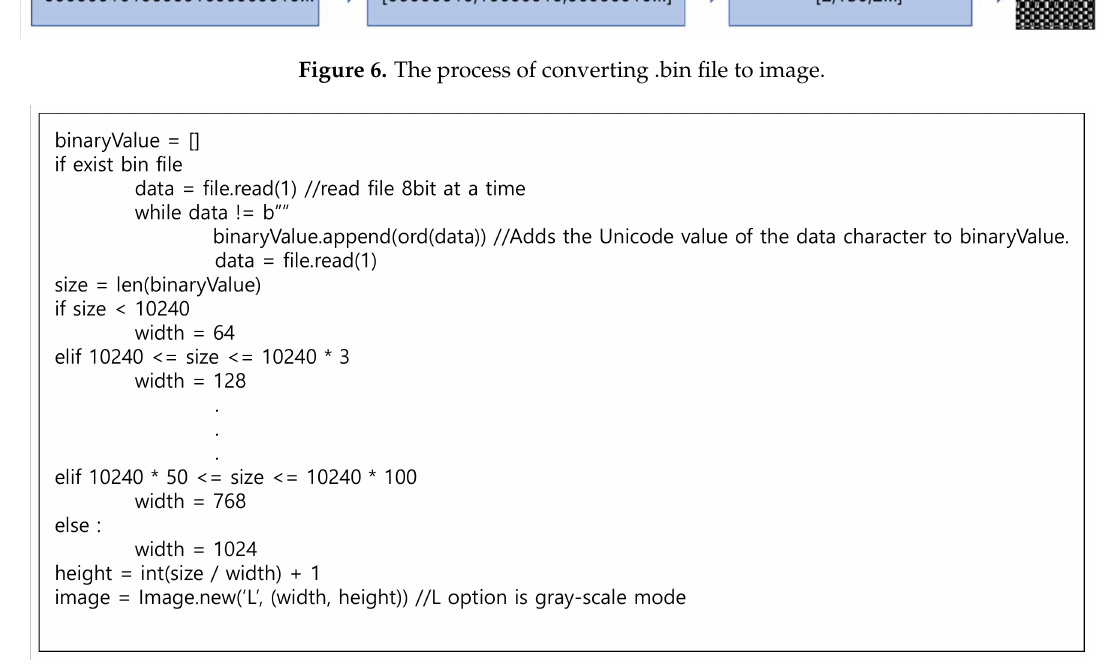
Figure 7. Pseudocode that converts binary to